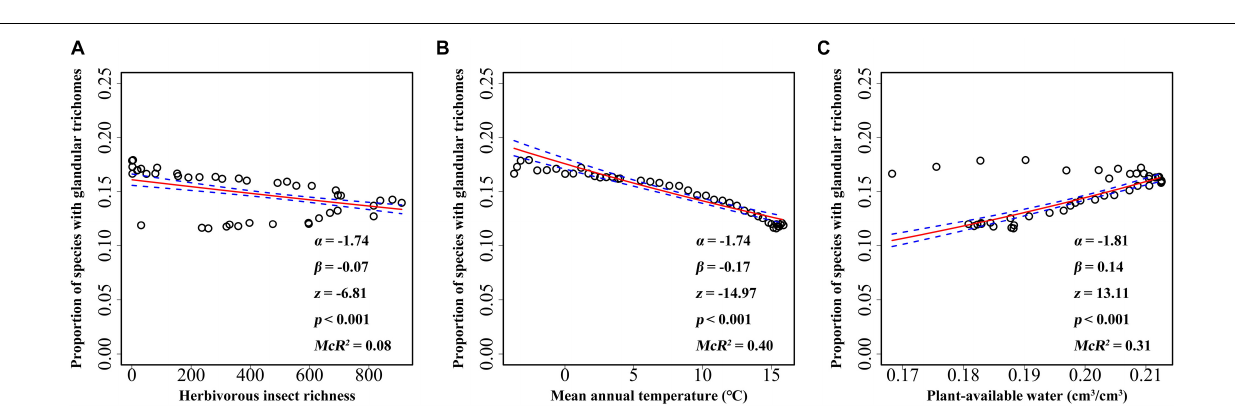
FIGURE 4 | The relationship between glandular trichome of plant species and herbivorous insect richness (A) , mean annual temperature (B) , and plant-available water (C) for every 100 m belt in the Hengduan Mountains region. The graphs were visualized according to the proportion of plants with glandular trichomes, but the analysis was based on the binary data of presence versus absence of plants with glandular trichomes. The fitted lines (solid line) and estimated 95% confidence intervals (dashed line) display the predicted probability of plants with glandular trichomes as fit by logistic regression models. α and β value was calculated after predictor variables being